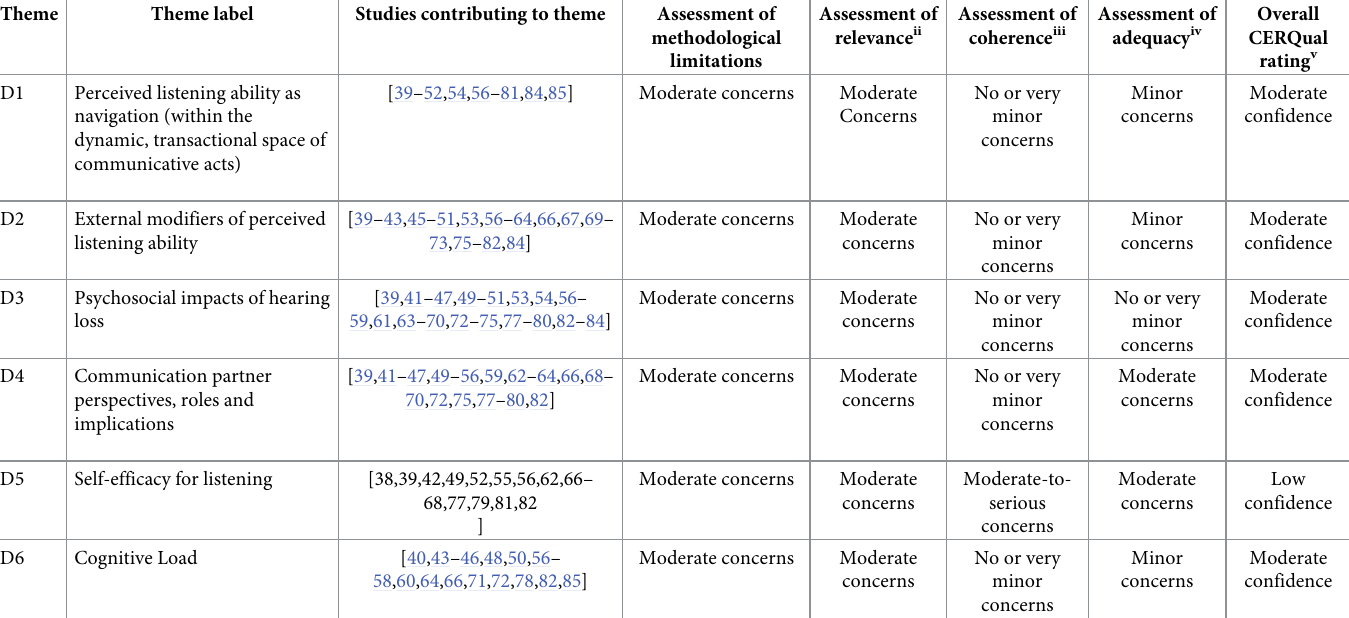
Table 4. Assessment of confidence of review findings: Summary score per GRADE CERQual